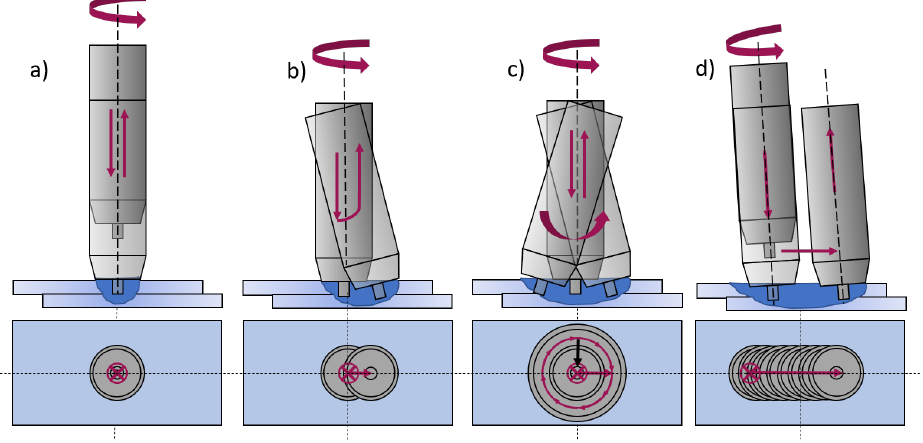
Figure 2. FSW and its modifications after [20,22]. ( a ) FSSW; ( b ) Swing-FSW; ( c ) Swing-FSW with a gyroidal movement; ( d )